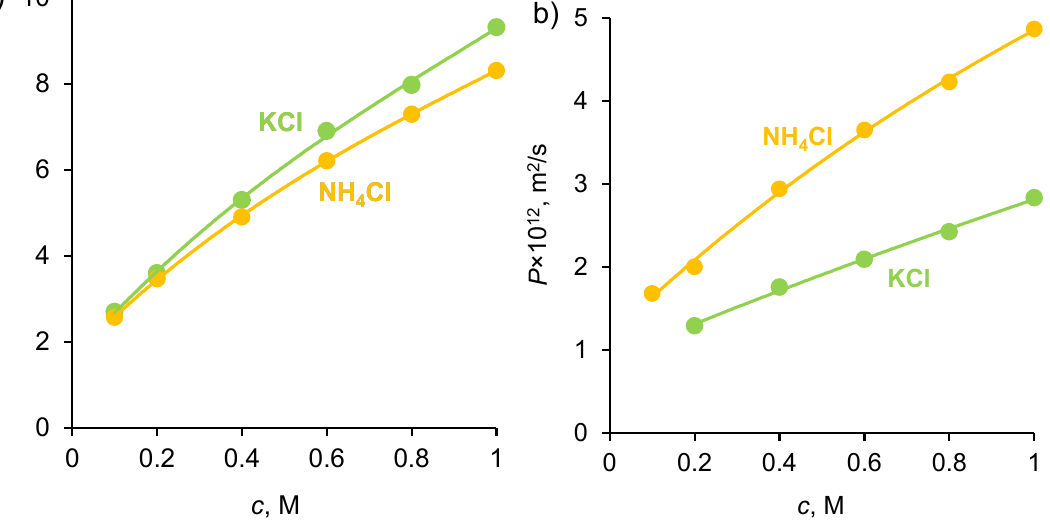
Figure 2. Integral diffusion permeability coefficient of CMX ( a ) and AMX ( b ) membranes in KCl and NH 4 Cl solutions. The dots are experimental data; the solid lines are presented to lead the eye.